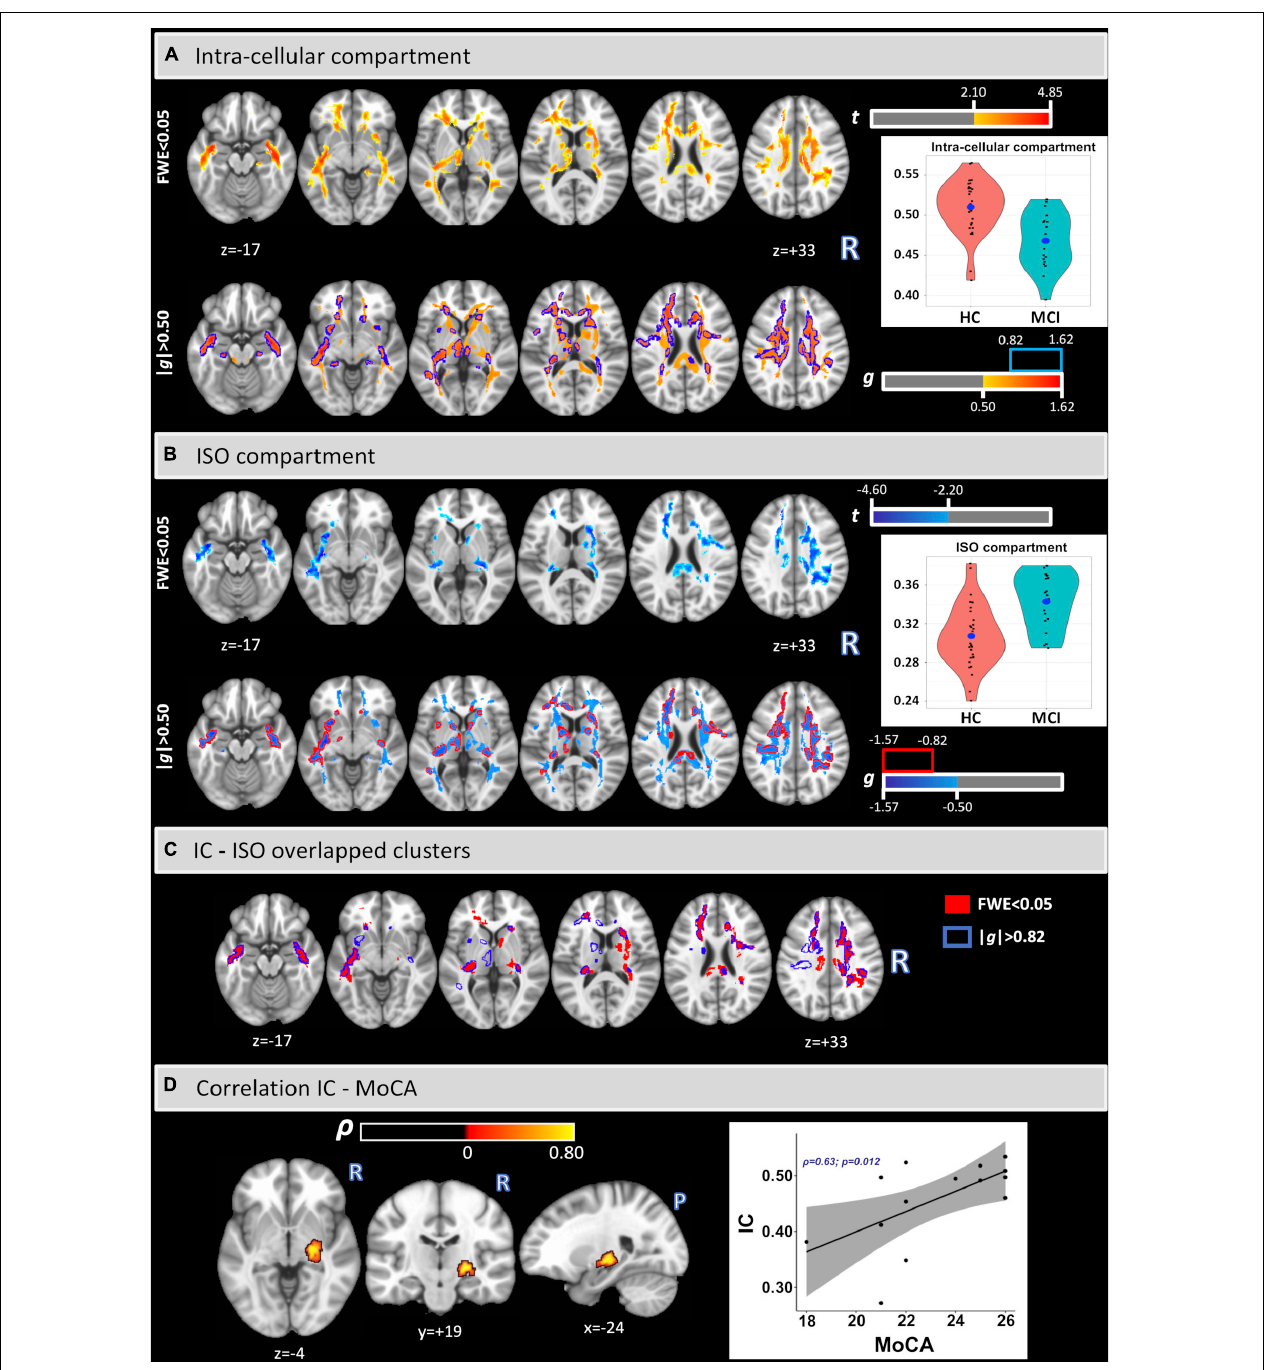
FIGURE 1 | Voxel-based analysis of IC and ISO signal fraction maps (A,B) . Lower IC and higher ISO values were found in MCI in several white matter regions and tracts. The clusters and the coordinates are in MNI152 space. Overlapped clusters by FWE < 0.05 and | g| > 0.82 (C) . Significant voxel-wise Spearman’s correlations were found between IC and MoCA scores in the MCI cohort (D)